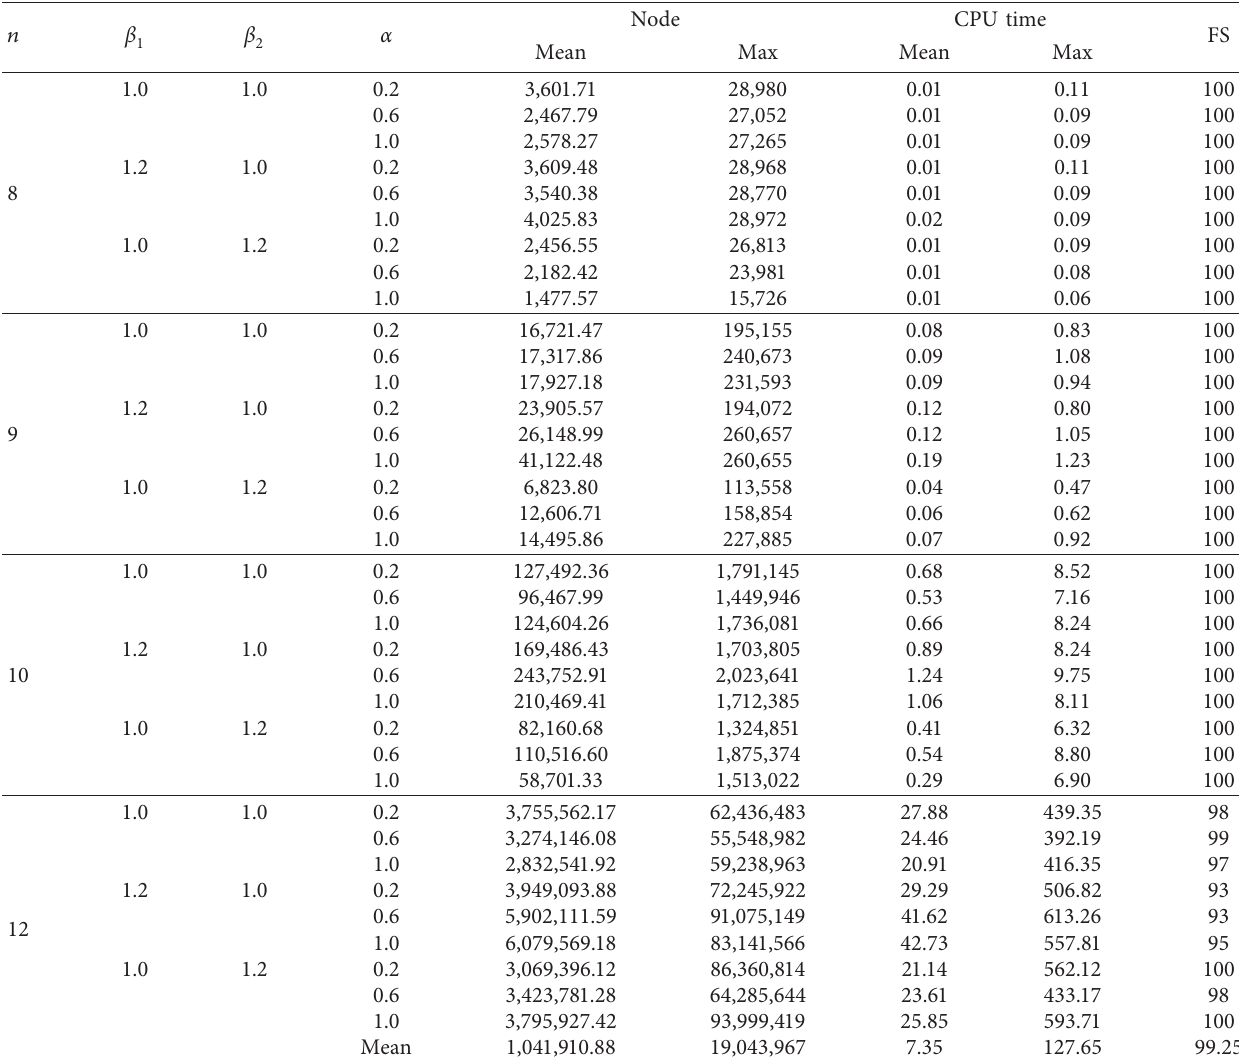
Table 1: The results obtained from the branch-and-bound